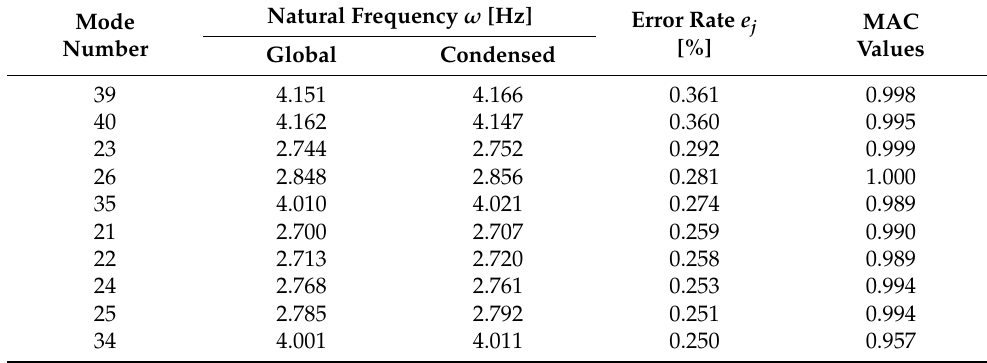
Table 1. Natural frequencies, error rates, and MAC values for 10 modes with the largest error.